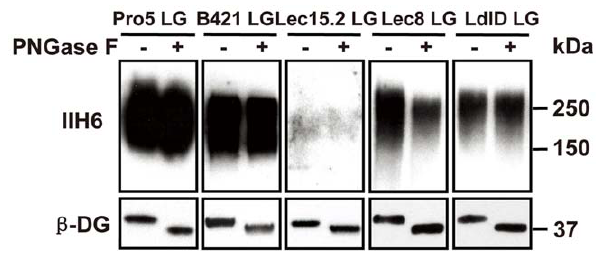
Figure 4. Effects of Large-induced pathway on N-linked glycans. (A) All cells were grown in the completed media as described in the methods section and the lysates harvested from the indicated cells with stably expressing LARGE were treated with pNGase F for 4 hours, while it is absent in the negative controls reactions as described in the methods section. IIH6 antibody was used to determine the LARGE induced glycans, and the anti- b -DG antibody was used to determine the b -DG proteins as described above. The blot of the Lec15.2 samples with the IIH6 antibody had 30 mins exposure, while all other blots had about 10 seconds’ exposure